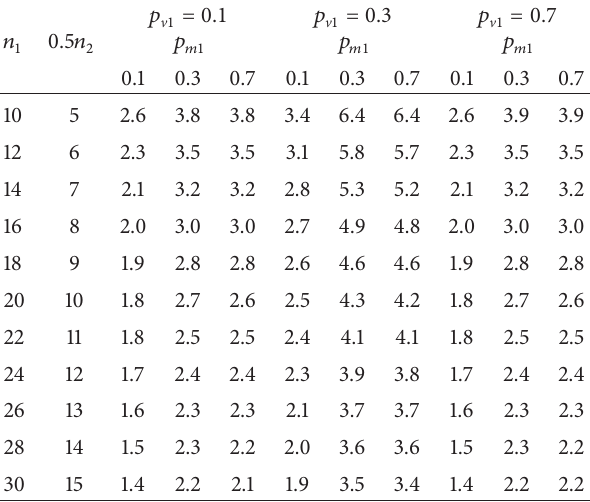
Table 10: The ARL 1 of the EWMA-AM and EWMA-AV charts for 𝜆